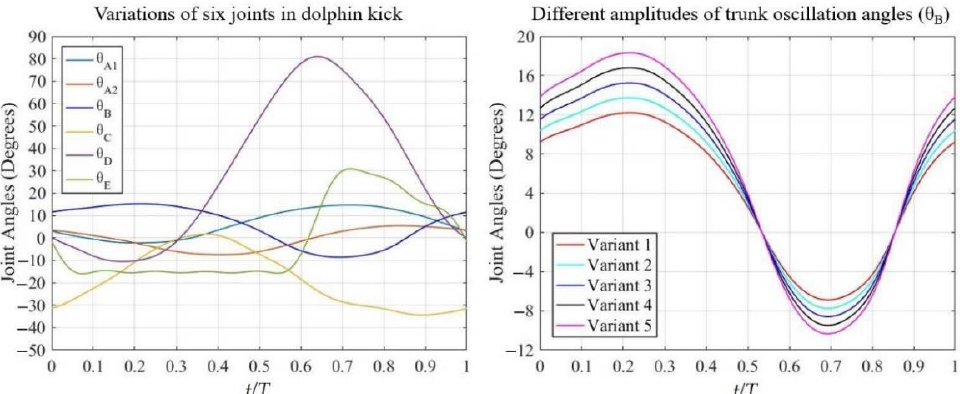
Figure 2. Variations of six joint angles in a dolphin kick cycle and five amplitudes of trunk oscillation angles.